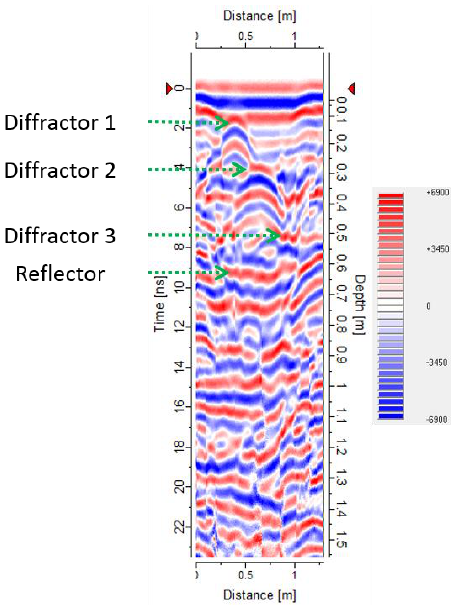
Figure 10. GPR section from laboratory experiment with central frequency of 800 MHz. The horizontal scale is the location of the measurement along the section, the left vertical scale is the signal travel time and the right vertical scale is the depth, assuming a uniform electromagnetic velocity of 0.125 m/ns. Amplitude scale is given on the right.